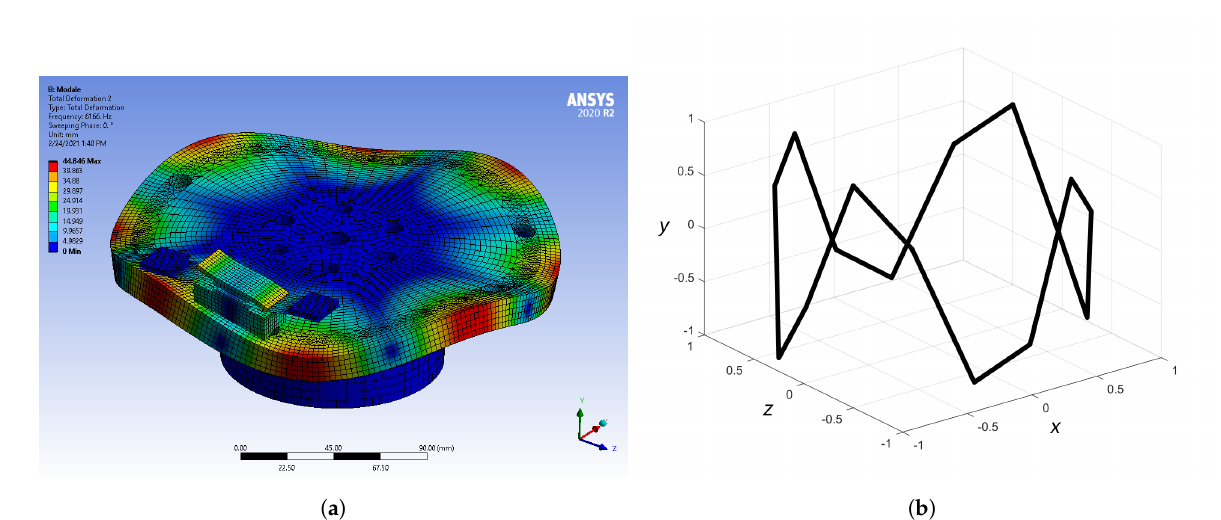
Figure 9. ( a ) Numerically obtained and ( b ) experimentally obtained mode shape corresponding to the (4,0) bending mode of the disc.